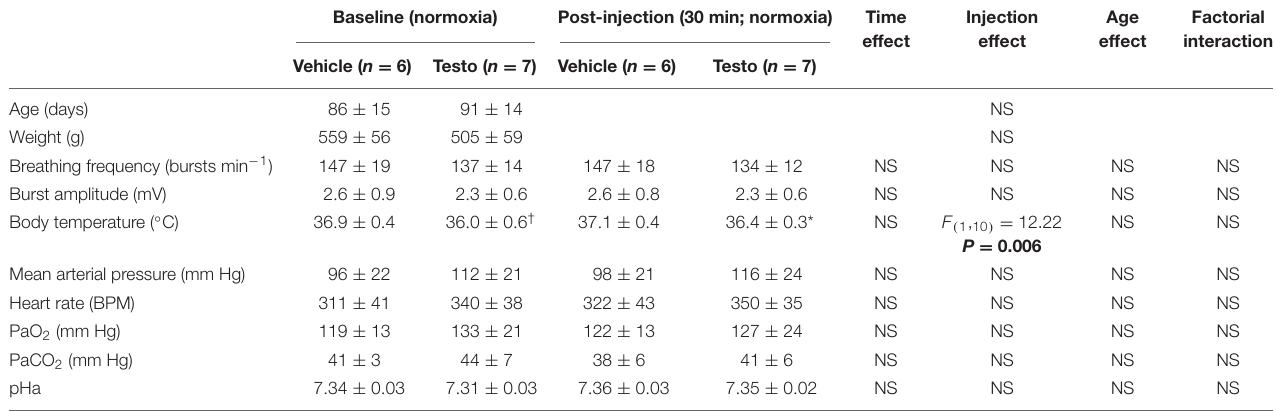
TABLE 1 | Effects of acute testosterone propionate injection (2 mg/kg. i.p.) on basic cardiorespiratory variables measured in anesthetized rats (urethane; 1.4 g/kg) prior to hypoxic